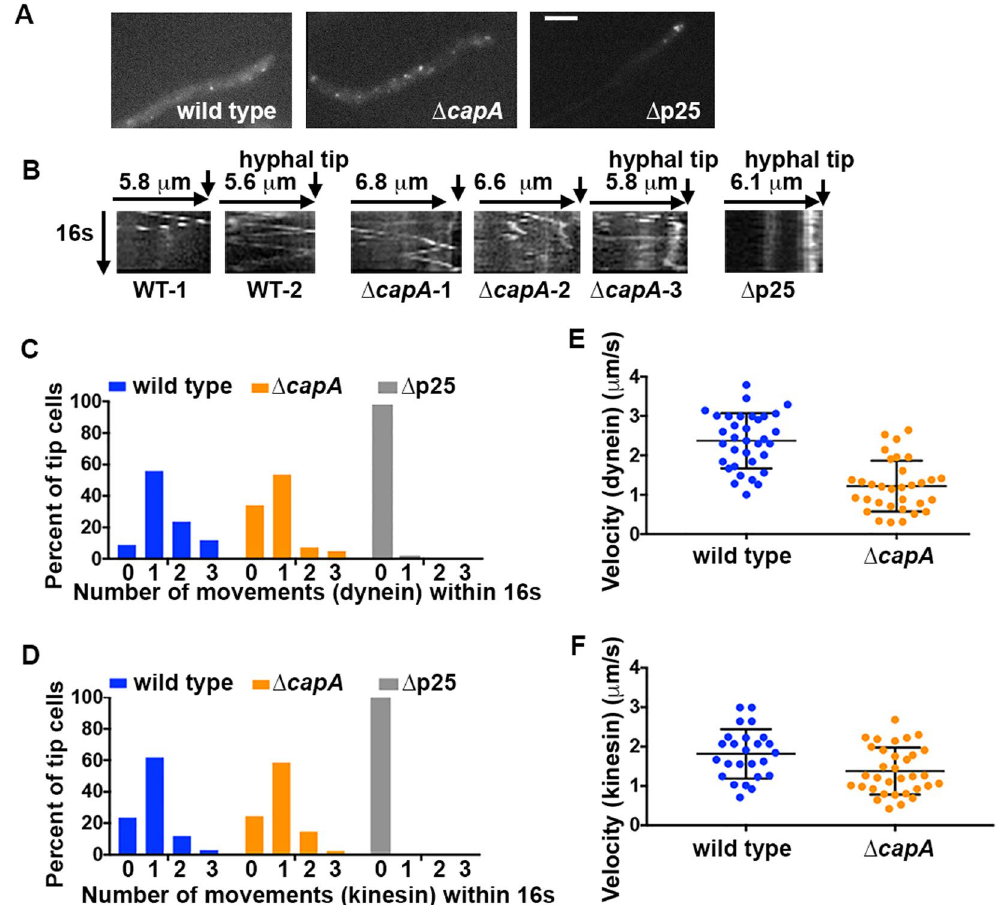
Figure 6. A quantitative analysis of dynein-mediated early endosome movement upon loss of CapA. ( A ) Images showing TagGFP2-RabA-labeled early endosomes in wild type, the ∆ capA mutant and the ∆ p25 mutant. Cells were cultured for overnight at 37 °C in MM + glycerol medium. Bar, 5 μ m. ( B ) Kymographs showing early endosome movements. Two kymographs are shown for wild type (WT-1 and WT-2) and three are shown for the ∆ capA mutant ( ∆ capA- 1, ∆ capA -2, and ∆ capA -3). A ∆ p25 kymograph is shown as a control as there is no diagonal lines that indicate movements. For each kymograph, position of the hyphal tip is on the right side and indicated by a short arrow (the word “hyphal tip” is on the last kymograph for each strain). ( C ) Percent of hyphal-tip cells (called “tip cells” for simplicity) showing different numbers of dynein-mediated early endosome movement events within 16 seconds (n = 34 for wild type and n = 41 for the ∆ capA mutant). The mean ranks of the wild type and ∆ capA numbers of events are significantly different at p = 0.05 ( p = 0.0022, two-tailed). ( D ) Percent of hyphal-tip cells showing different numbers of kinesin-3-mediated early endosome movements within 16 seconds (n = 34 for wild type and n = 41 for the ∆ capA mutant). The mean ranks of the wild type and ∆ capA numbers of events are not significantly different at p = 0.05 ( p = 0.962, two-tailed). ( E ) Velocity of dynein-mediated early endosome movement in wild type and the ∆ capA mutant (n = 34 for wild type and n = 32 for the ∆ capA mutant). The mean ranks of the two sets of values are significantly different at p = 0.05 ( p = 0.000000008666721, two-tailed). ( F ) Velocity of kinesin-3-mediated early endosome movement in wild type and the ∆ capA mutant (n = 25 for wild type and n = 33 for the ∆ capA mutant). The mean ranks of the two sets of values are significantly different at p = 0.05 ( p = 0.013, two-tailed). Scatter plots with mean and SD values were generated by Prism 7. All the statistical analyses were done using nonparametric tests assuming no information about the distribution (unpaired, Mann-Whitney test, Prism